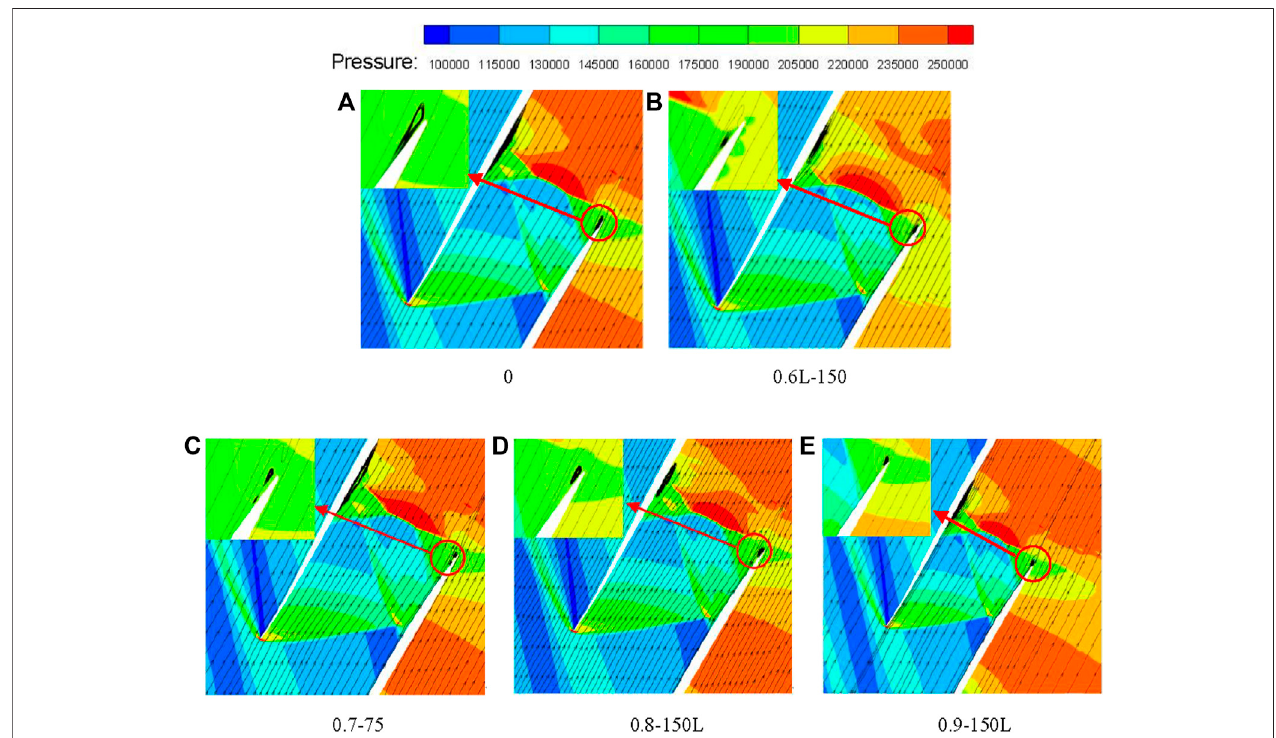
FIGURE 11 | Pressure contours of the supersonic cascade and Partially enlarged.